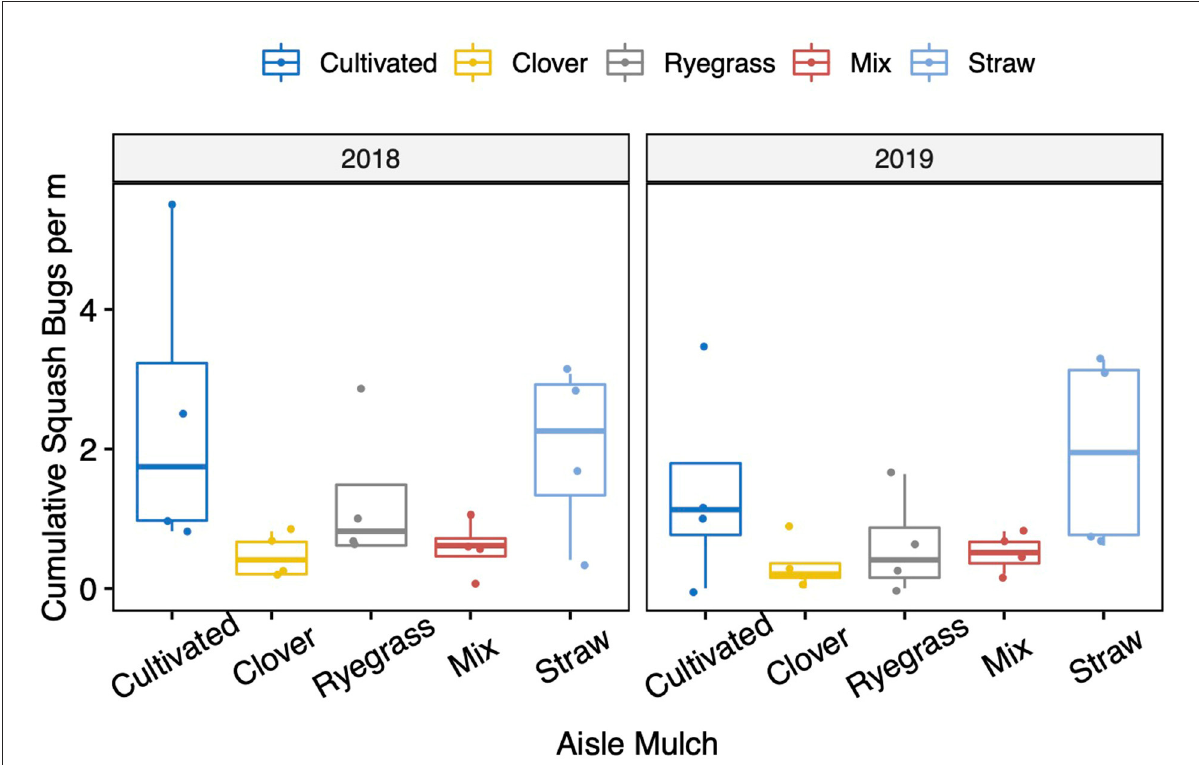
FIGURE4 Cumulative squash bugs m − 1 on organic zucchini plants grown using cover crop living mulches, 2018 and 2019. There was no interaction between year and aisle mulch, but across both years clover had significantly fewer squash bugs m − 1 than cultivated or straw mulched